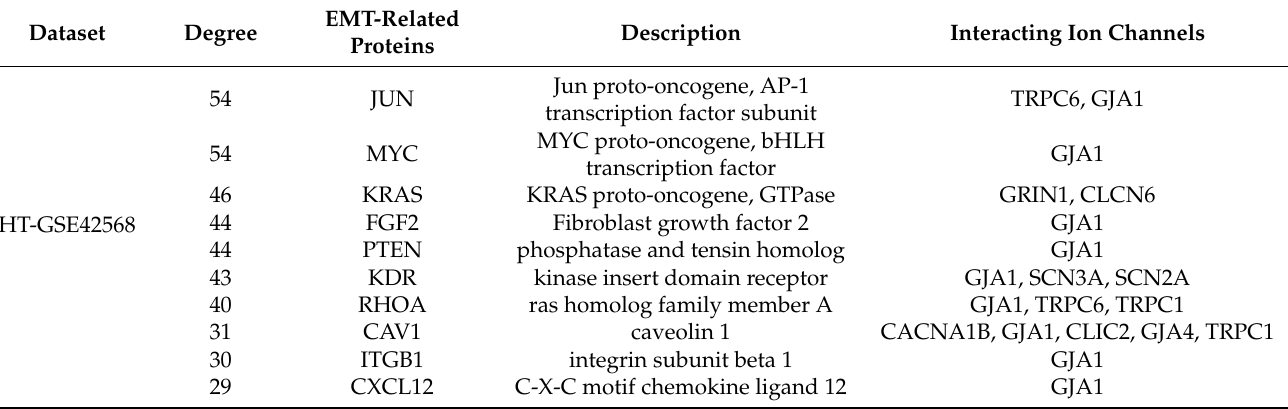
Figure 4. Representation of protein–protein interaction networks (PPINs) of combined gene set. Nodes in the shade of blue represent EMT-related genes and yellow nodes represent ion channels. The nodes are arranged based on the degree centrality measure. Larger nodes represent nodes with high degree centrality. ( A ) PPINs for microarray dataset (GSE42568) based on the list of non- redundant HT DEGs. ( B ) PPINs for microarray dataset (GSE42568) based on the list of non-redundant HM DEGs. Table 4. A list of ion channels interacting with the top 15 EMT-related proteins with the highest degree centrality measure in protein–protein interaction networks of modules on HT DEGs in breast cancer GSE42568